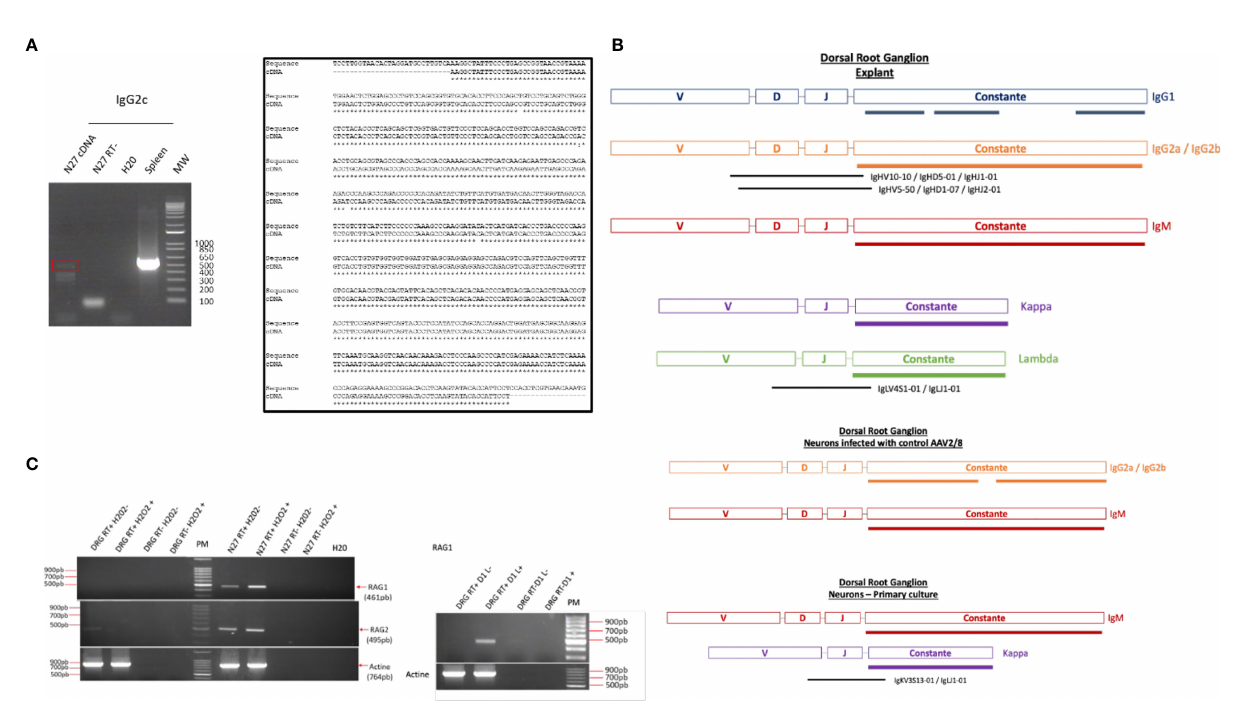
Table S1 ) (C) Ampli fi cation of Rag1 and Rag2 mRNA in DRG and N27 cells was carried out by RT-PCR in presence of H 2 O 2 to induce neuronal death, as observed during the spinal cord injury. Since expression of RAG1 encoding gene was not observed under these conditions, DRG cells were cultivated in the presence of secretome of lesion segment from 1 day after SCI following by RT-PCR. As a control to exclude genomic DNA contamination, the experiment was also carried out on a negative reverse transcriptase sample (RT-), H 2 0, negative